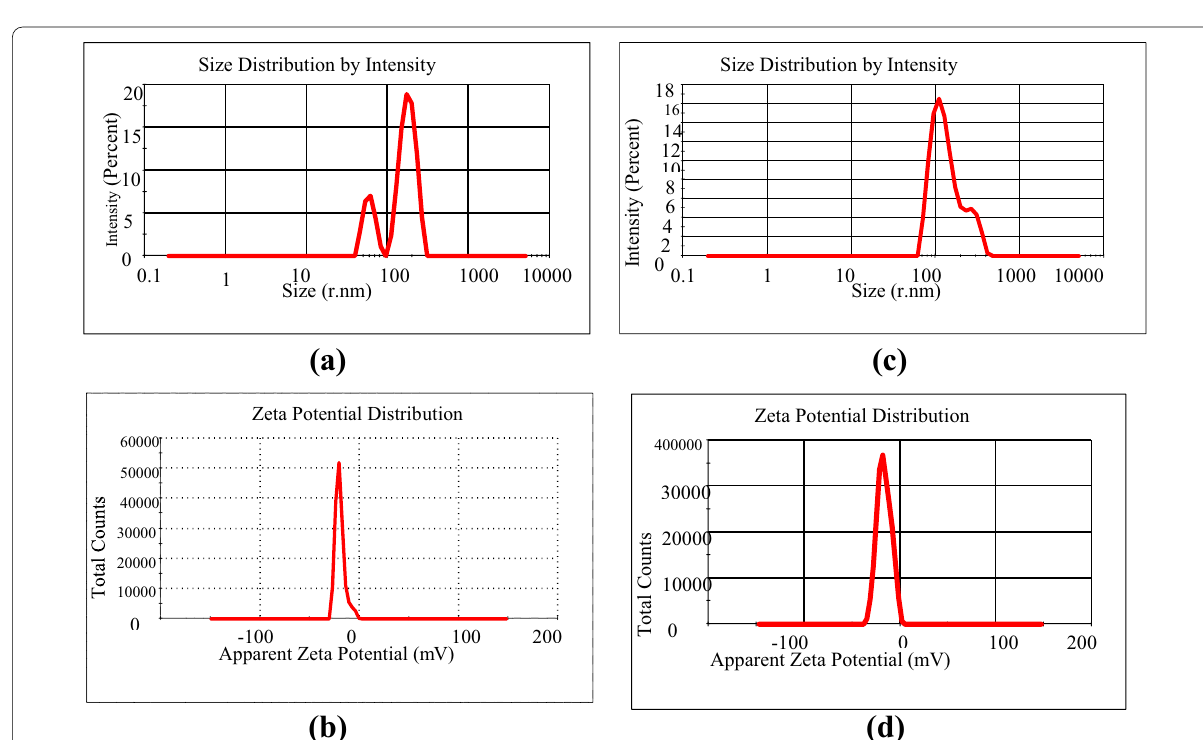
Fig. 4 DLS and Zeta Potential analysis of T. Purpureogenus AgNPs showing. a Size distribution by intensity first day. b Zeta Potential Distribution First day. c Size distribution by intensity after 60 days. d Zeta Potential Distribution after 60